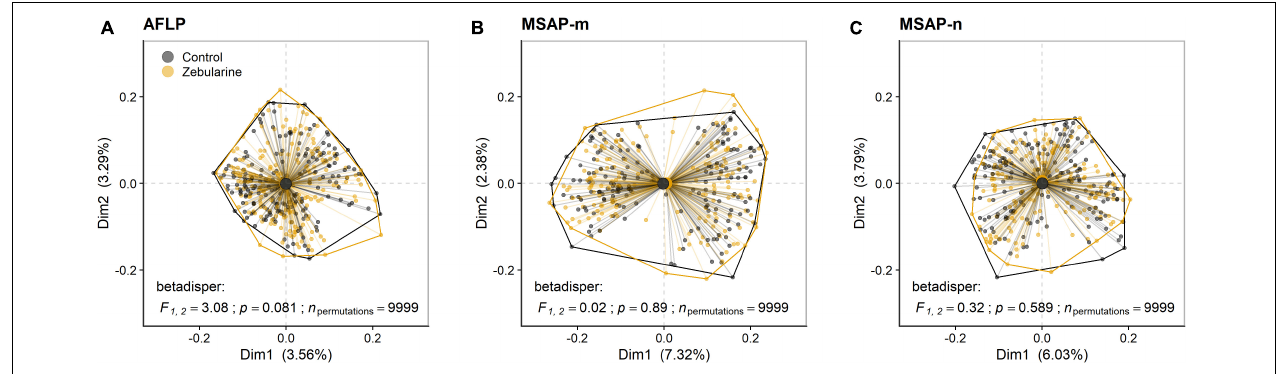
FIGURE 2 | Biplots of principal coordinates analysis (PCoA) based on genetic (AFLP) and epigenetic (MSAP-m, MSAP-n) datasets from 25 S. canadensis populations. The first two PCoA axes (Dim1, Dim2) denote the explained variances for (A) genetic loci (AFLP), (B) methylated epigenetic loci (MSAP-m), and (C) non-methylated epigenetic loci (MSAP-n) for both control (black) and zebularine-treated individuals (orange). Group dispersion is displayed with convex hulls and group centroids. Dissimilarity between samples was determined using the Sørensen-Dice index and multivariate homogeneity of group dispersion (betadisper) was assessed at the significance level of p < 0.05 using permutation tests (n permutations = 9,999). F , empirical F -distribution value with corresponding degrees of freedom.